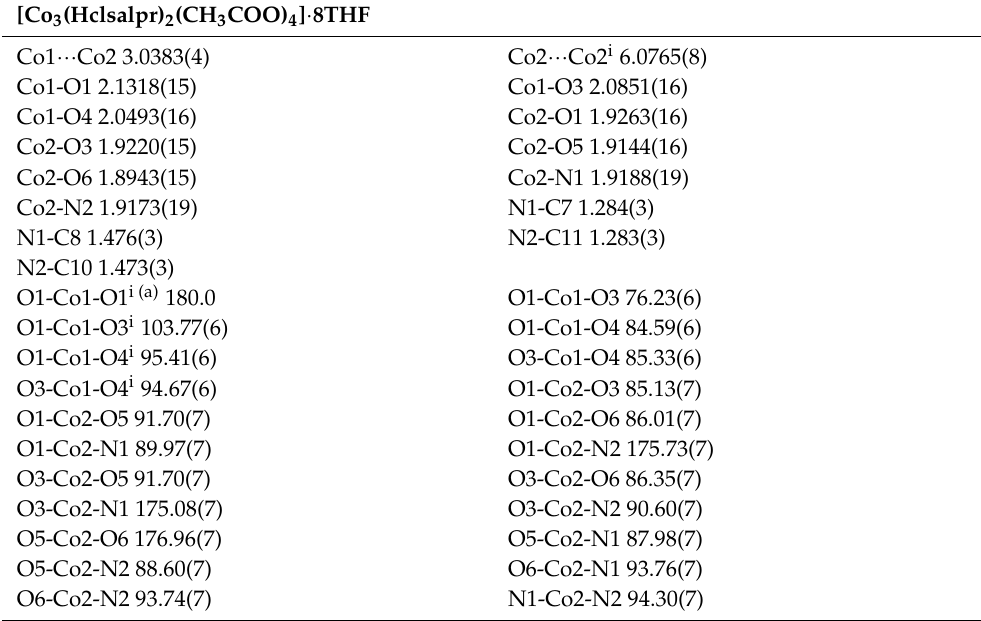
Table 2. Selected bond distances (Å) and angles ( ◦